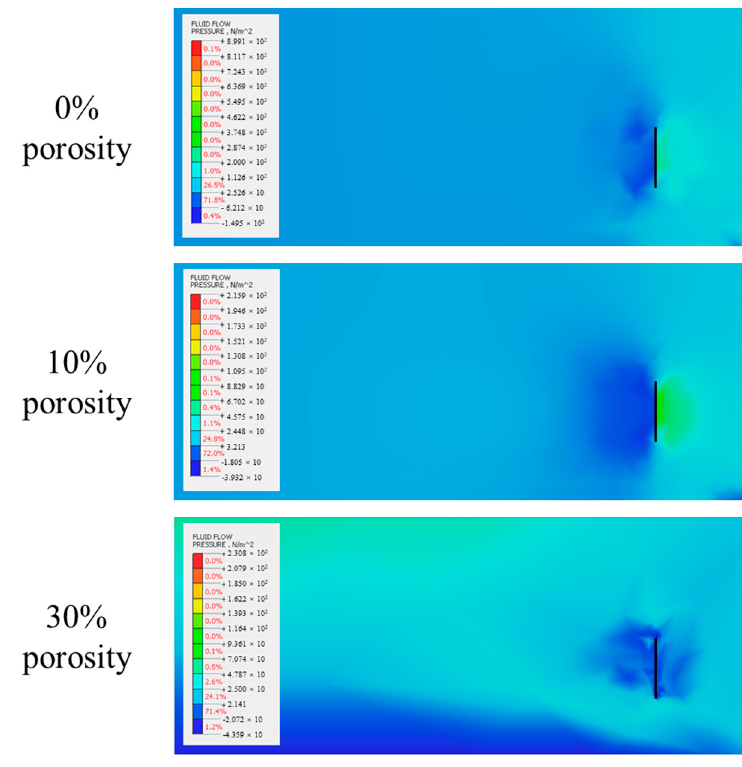
Figure 7. Wind speed distribution of perforated road sign by porosity.